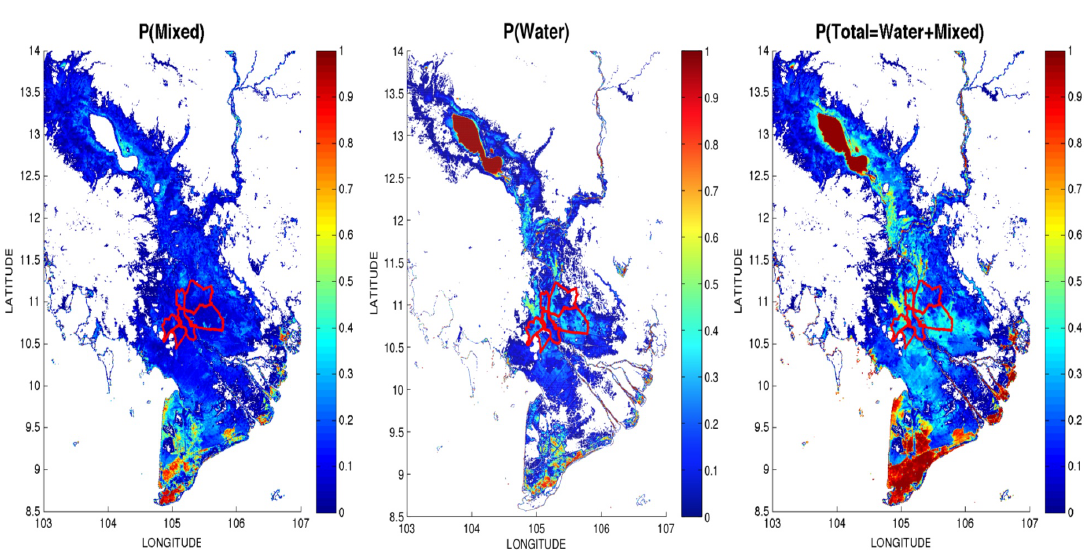
Figure 3. Probability of mixed ( left ), water ( middle ), and total = mixed + water ( right ) pixels, over the 2001–2017 period, over the Lower Mekong Basin. The six zones considered in this study over the Cambodia-Vietnam frontier (Figure 1 and Table 1) are represented in red.